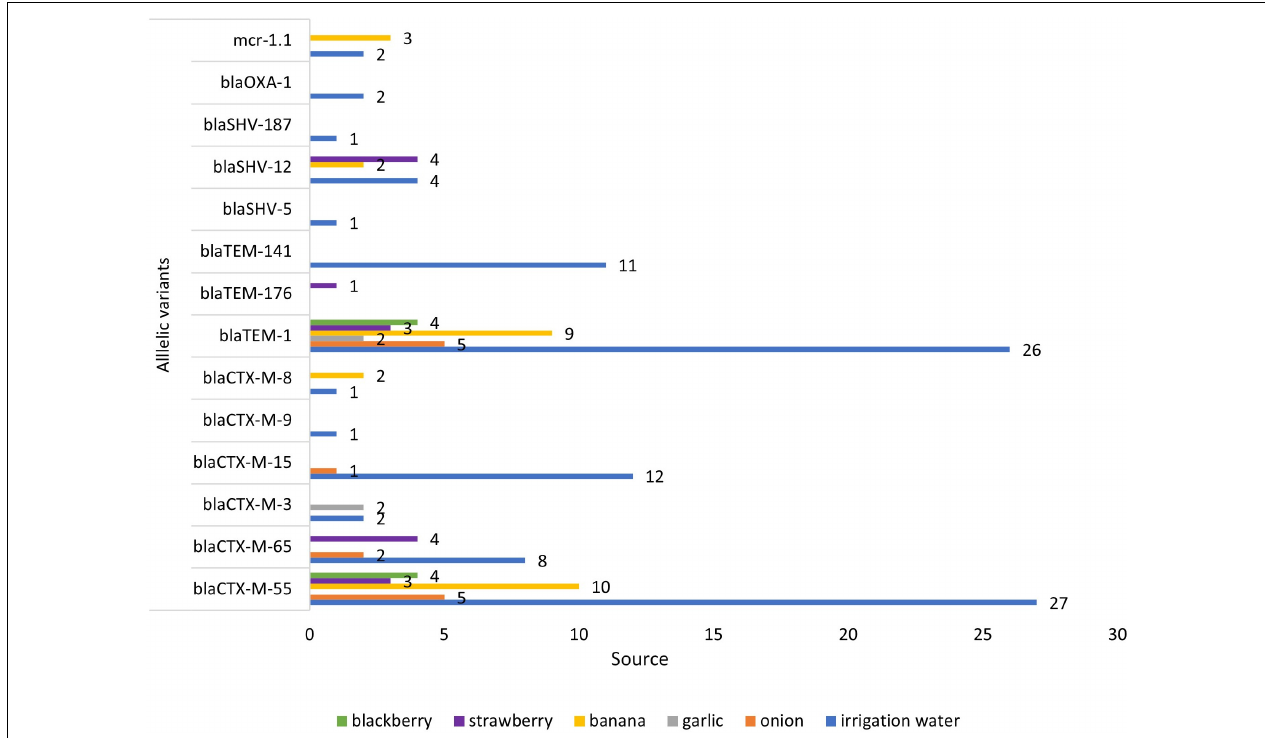
FIGURE 3 | Phylogenetic tree of ESBL- E.coli sequences from irrigation water, fruits, and vegetables. Maximum likelihood phylogenetic tree of the core genomes of 80 ESBL- E.coli isolates from irrigation water, fruits, and vegetables. The labels show the isolate ID assigned according to the sample ID, the origin of the isolate is shown by source colors (irrigation water: blue, onion: brown, banana: yellow, blackberry: purple, strawberry: red, and garlic: green). The background colors highlighted on the branches of the tree indicate the seven identified phylogroups. Numbers represent bootstrap values using 1,000